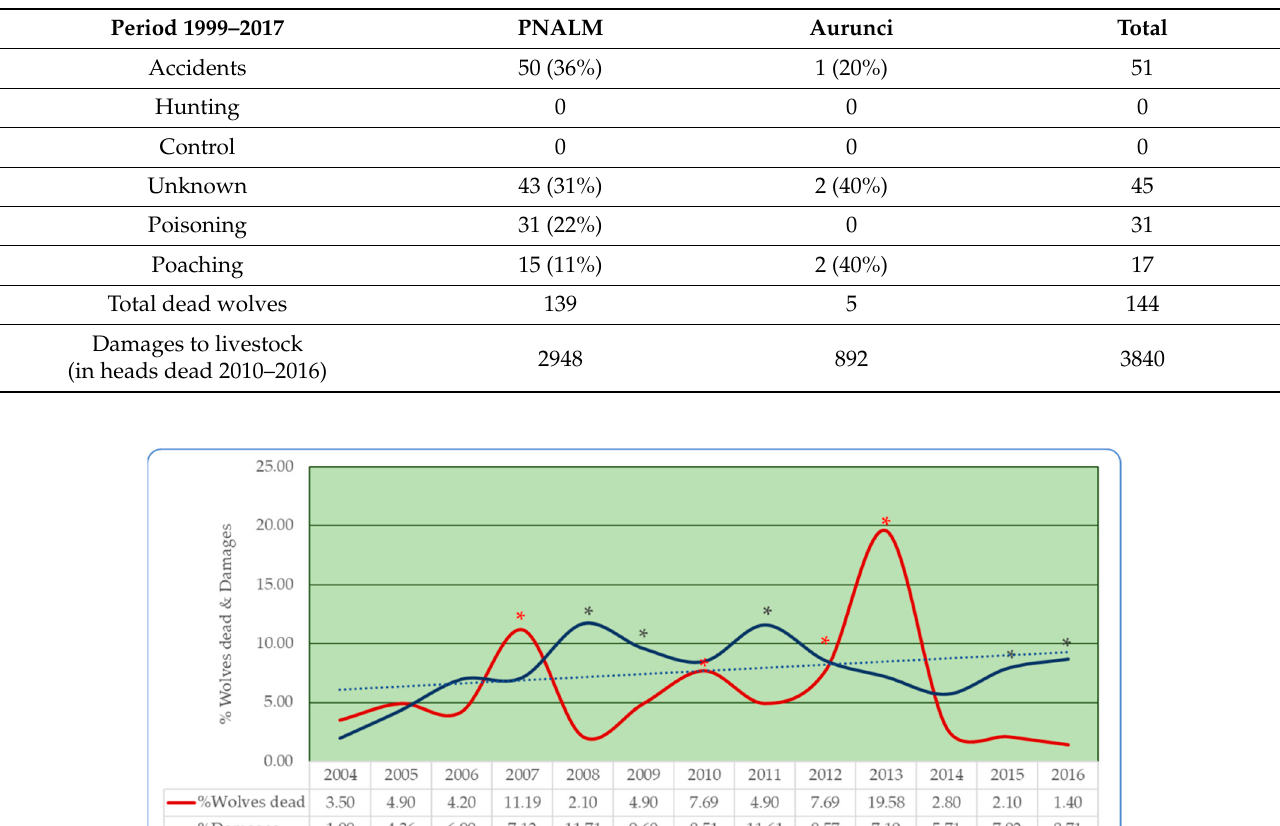
Table 4. Number of wolves founded dead in the samples studied areas of Italy (National Park Abruzzo, Lazio, and Molise = PNALM; Regional Park of Aurunci Mountain = Aurunci).